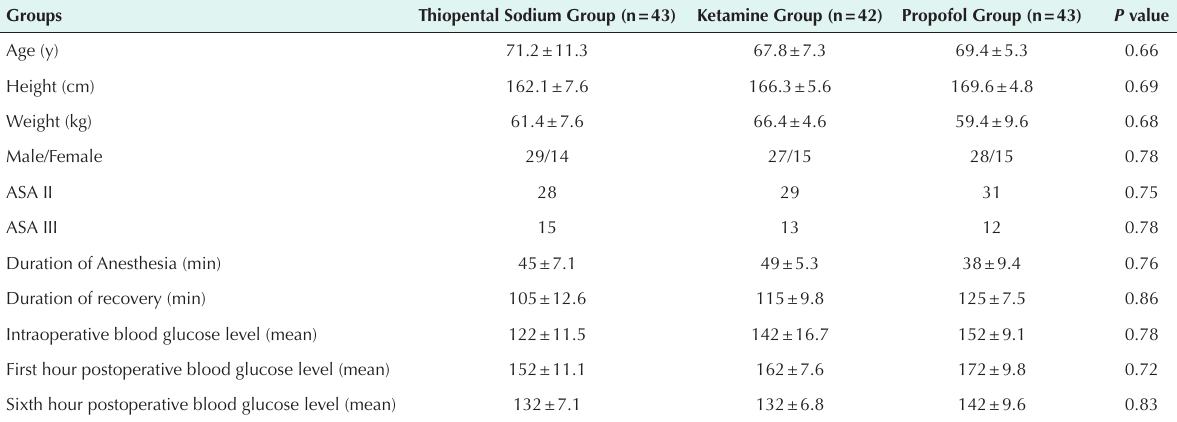
Table 1. Demographic and Operative Details of Patients in Three Groups